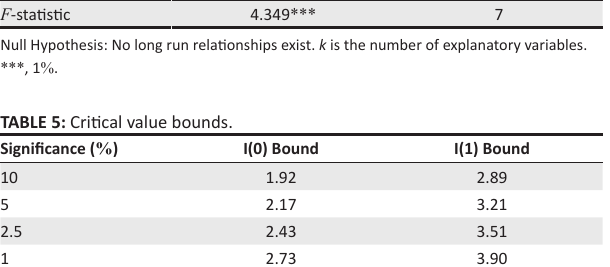
TABLE 4: Autoregressive distributed lag bounds test results. Test Statistic